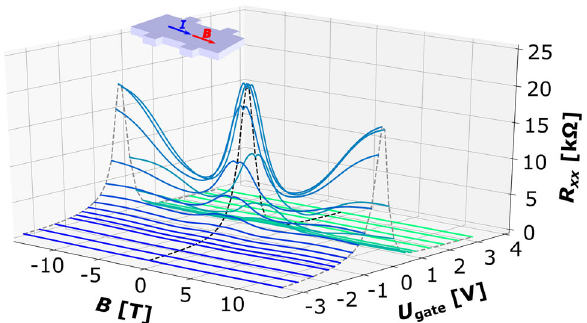
FIG. 4. R xx as a function of the magnetic field applied parallel to the current for different gate voltages. The dashed lines represent R xx as a function of the applied gate voltage for zero (black) and maximum magnetic field ( (cid:2) 14 T) (gray).